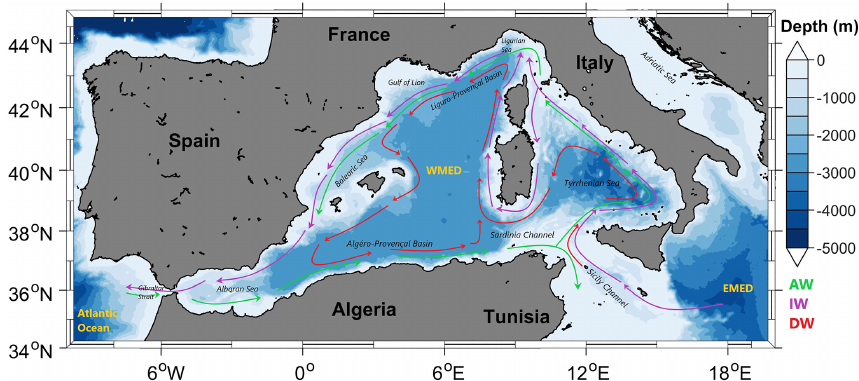
Figure 1. Map of the western Mediterranean Sea showing the main regions with a sketch of the AW, IW and DW major paths. Table 1. Overview of the existing inorganic nutrient climatologies in the western Mediterranean